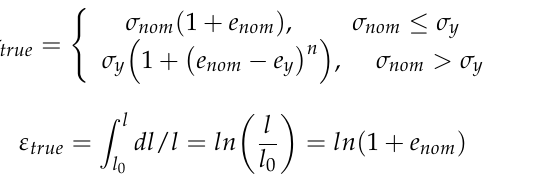
Figure 14. Comparison of fracture strain retention between PC, PP, PBT, and PE during 4-year weathering test. Midpoint positions ( D 0 , open circles) are shown for each polymer.